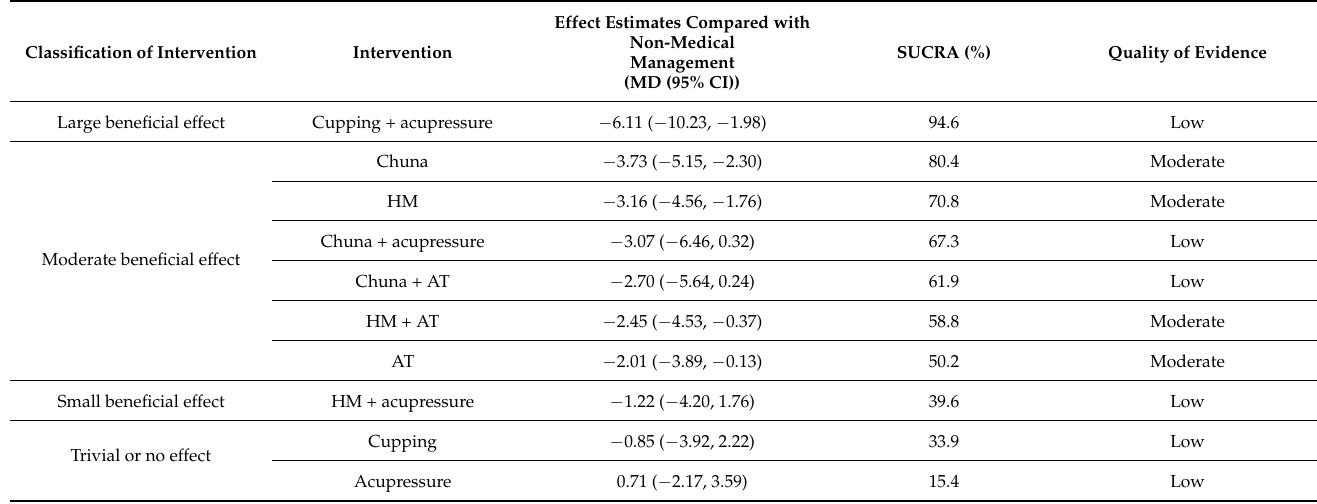
Table 3. GRADE approach using a partially contextualized framework: body mass index.